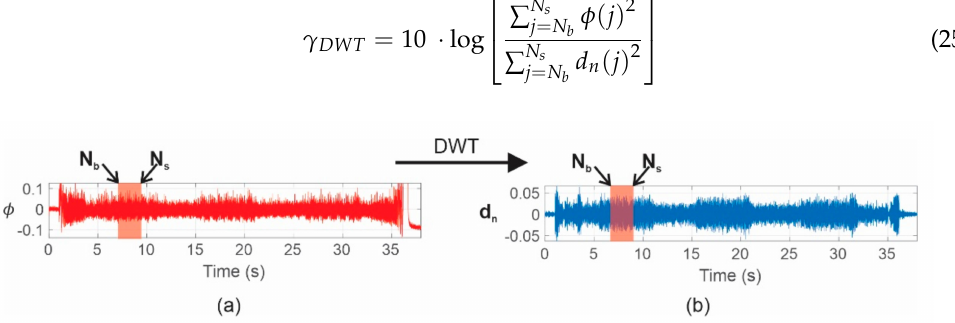
Figure 5. Rectangular window considered to compute γ DWT by analyzing the wavelet signal, d n : ( a ) stray flux captured by the sensor. ( b ) wavelet signal containing the majority of the fault frequency